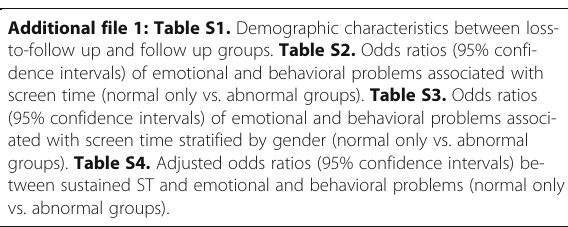
Additional file 1: Table S1. Demographic characteristics between loss- to-follow up and follow up groups. Table S2. Odds ratios (95% confi- dence intervals) of emotional and behavioral problems associated with screen time (normal only vs. abnormal groups). Table S3. Odds ratios (95% confidence intervals) of emotional and behavioral problems associ- ated with screen time stratified by gender (normal only vs. abnormal groups). Table S4. Adjusted odds ratios (95% confidence intervals) be- tween sustained ST and emotional and behavioral problems (normal only vs. abnormal